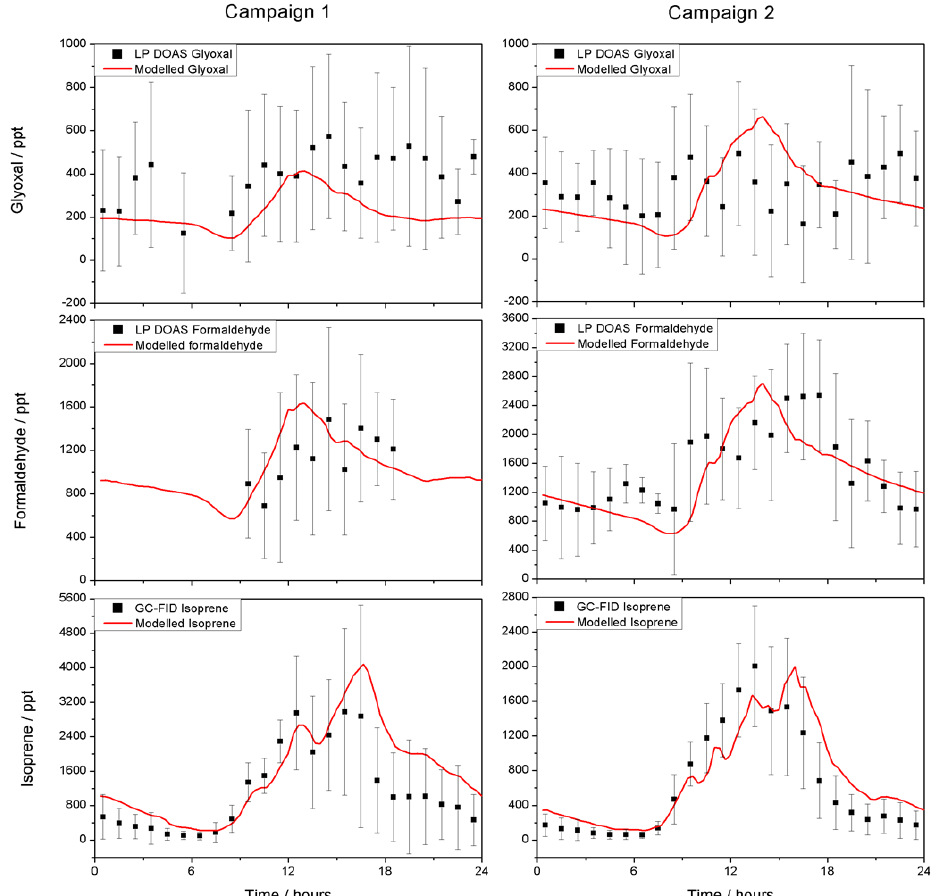
Fig. 10. Average diurnal profiles for glyoxal and formaldehyde measured by LP-DOAS, and isoprene measured by GC-FID, for campaigns 1 and 2. The black squares show the measured average and associated 1 σ standard deviation, the red lines show the modelled glyoxal and formaldehyde averaged over the first 180m and the modelled isoprene at